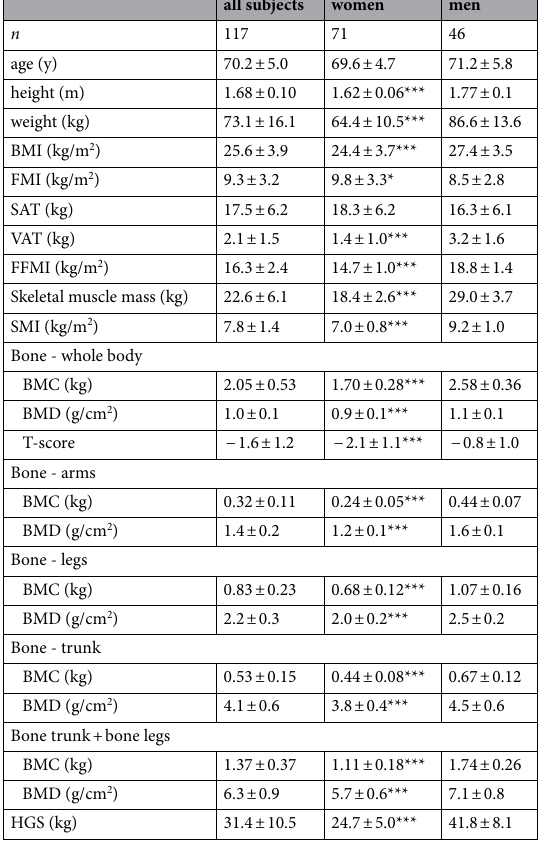
Table 1. Characteristics of the study population. Values are means ± SD. BMI, body mass index; FMI, fat mass index; SAT, subcutaneous adipose tissue; VAT, visceral adipose tissue; FFMI, fat-free mass index; SMI, skeletal muscle mass index; BMC, bone mineral content; BMD, bone mineral density; HGS, hand grip strength. * p < 0.05, *** p < 0.001 sex differences by t -test. Bone parameters were not adjusted for body weight.